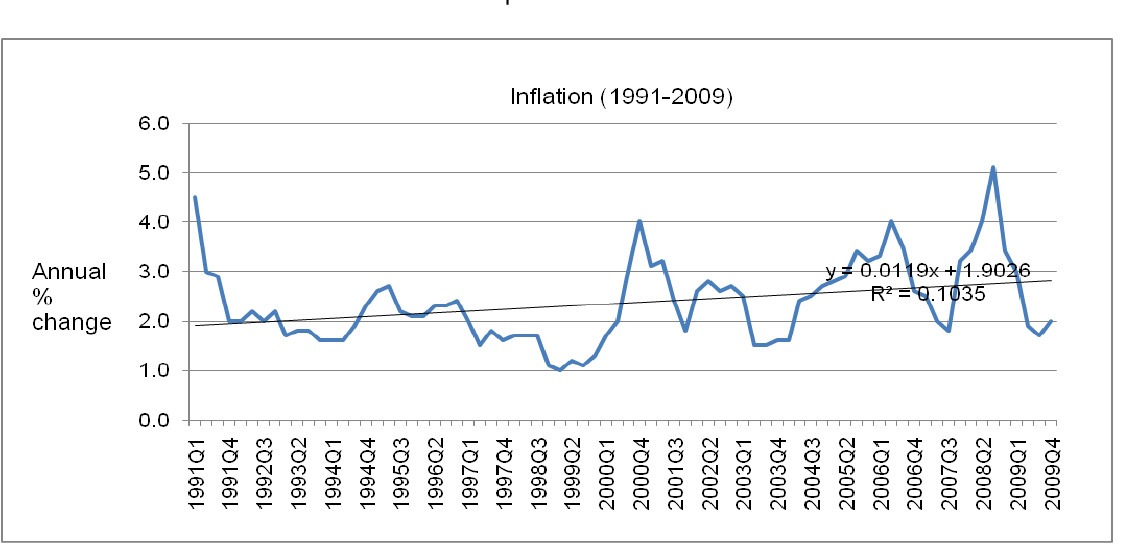
Figure 3 NZ Inflation 1991-2009 Source: SNZ, RBNZ. Note: Interest rates are